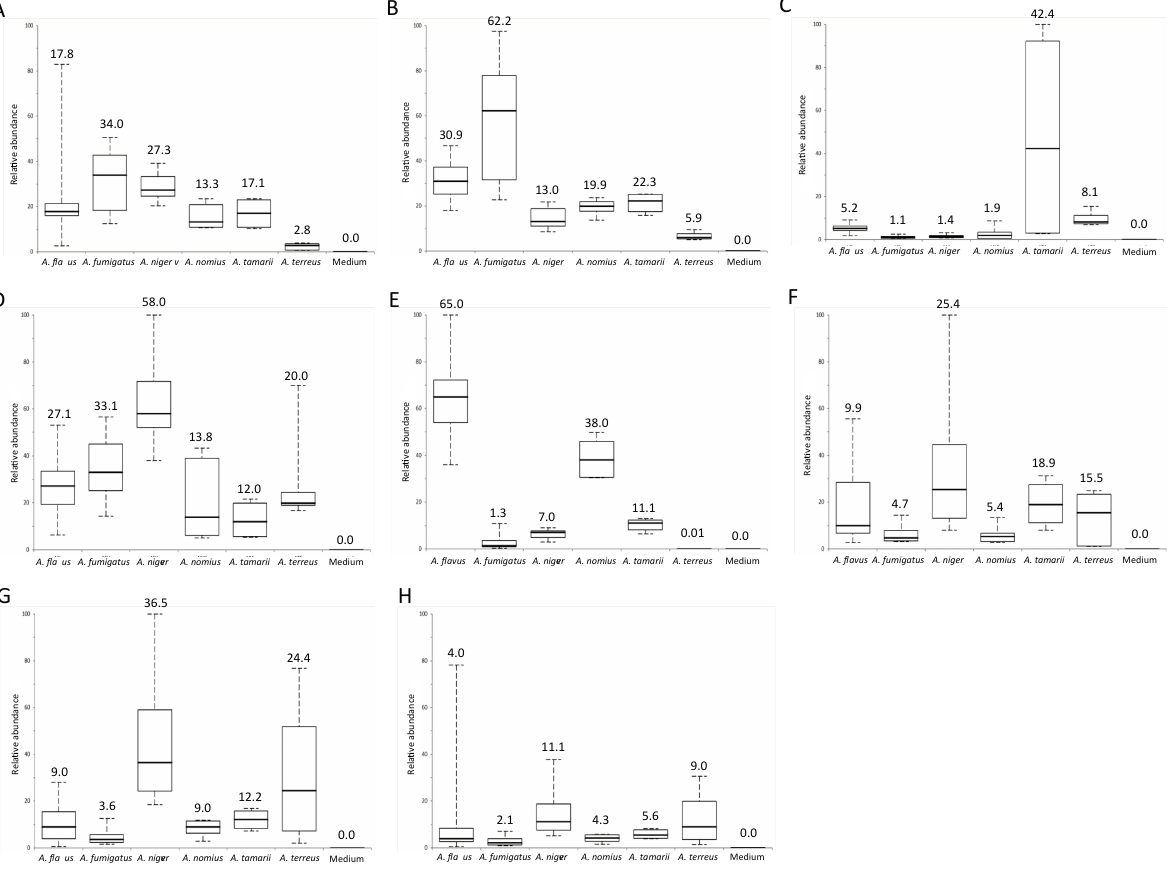
Figure 4. Comparison of abundance of metabolites specific to the six Aspergillus species. Box-and-whisker plots of ( A ) 7-methylguanine; ( B ) 1-methylguanine; ( C ) hydroxyl(sulfooxy) benzoic acid; ( D ) (sulfooxy)benzoic acid; ( E ) Leu–Glu–Leu–Glu; ( F ) metabolite with protonated molecular ion of m / z 292.2645 eluted at 19.55 min; ( G ) metabolite with protonated molecular ion of m / z 352.2466 eluted at 28.5 min; ( H ) metabolite with protonated molecular ion of m / z 352.2466 eluted at 28.8 min. Boxes show first to third quartiles; whiskers show 5% and 95% percentiles; middle lines in boxes and numbers on the top of boxes indicate the median of the relative abundance of